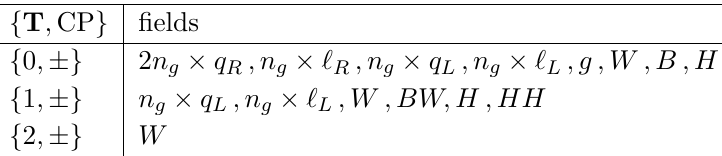
Table 1 . The 60 PDFs required for the SM evolution can written in a basis with de(cid:12)nite conserved quantum numbers. 2(5 n g + 4) FFs contribute to the f 0 ; (cid:6)g states, 2(2 n g + 4) to each to the f 1 ; (cid:6)g and 2 to the f 2 ; (cid:6)g , where n g = 3 stands for number of